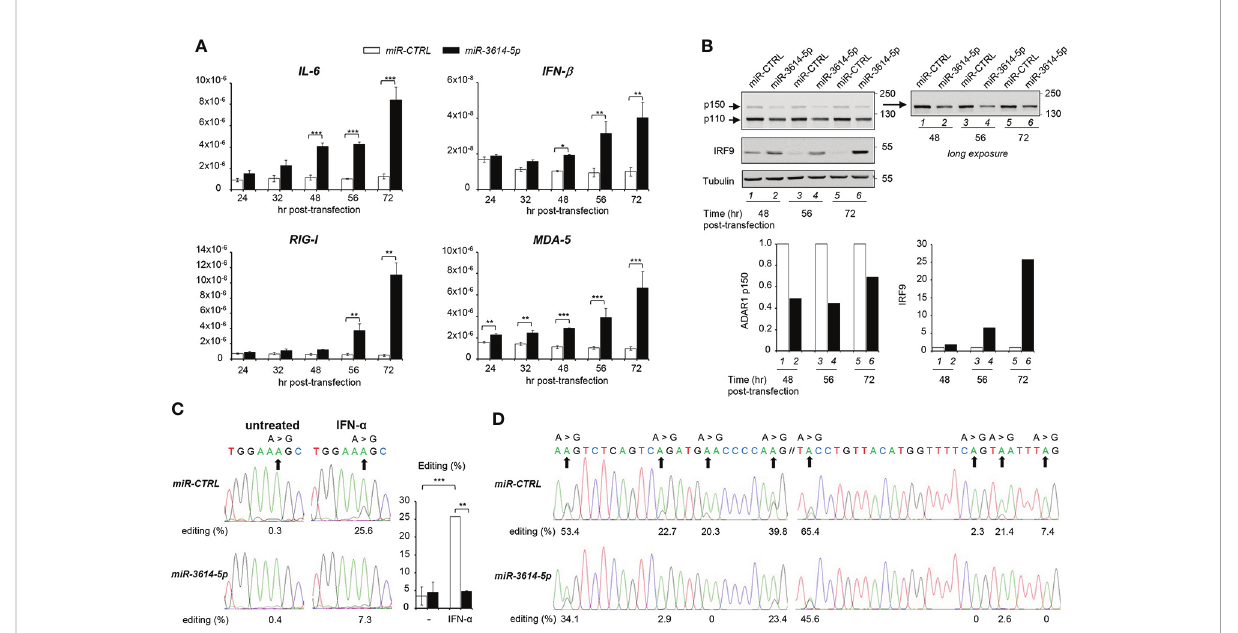
FIGURE 4 MiR-3614-5p impacts innate cytokine expression and RNA editing. (A) HeLa cells were retrotransfected with the mir-3614-5p or the miR- control (miR-CTRL) as mimics. The relative expression of IL-6 , IFN- b , RIG-I and MDA-5 was measured at different times after retrotransfection, as indicated. Values are means ± SEM (n=3 separate experiments); *p<0.05; **p<0.01; ***p<0.001. (B) Cells retrotransfected as in A) were lysed for western blot analysis at different times post-transfection. Lysates were immunoblotted as indicated. Tubulin was used as loading control. Right panel, the membrane was covered below the 130 kDa marker and exposed for longer time to better visualize the p150 ADAR1 isoform. Protein bands were quanti fi ed and normalized to tubulin. Results are expressed as ratios of miR-3614-5p- transfected cells (black) relative to miR-CTRL-transfected cells (white). Values in miR-CTRL-transfected cells were set to 1. These data are representative of